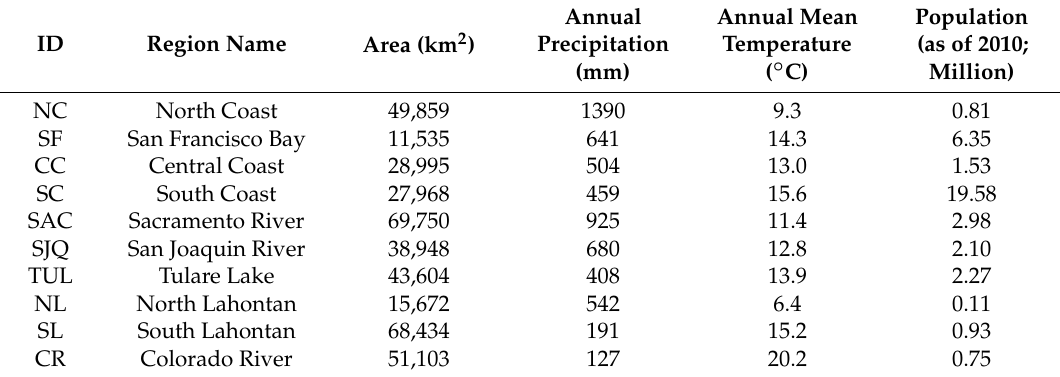
Figure 1. Ten hydrologic regions in California: North Coast (NC), San Francisco Bay (SF), Central Coast (CC), South Coast (SC), Sacramento River (SAC), San Joaquin River (SJQ), Tulare Lake (TUL), North Lahontan (NL), South Lahontan (SL), and Colorado River (CR). Dots represent the centroid points of individual climate projection grids (1/16th degree) located in each region. Table 1. Geographic and climatic characteristics of study hydrologic